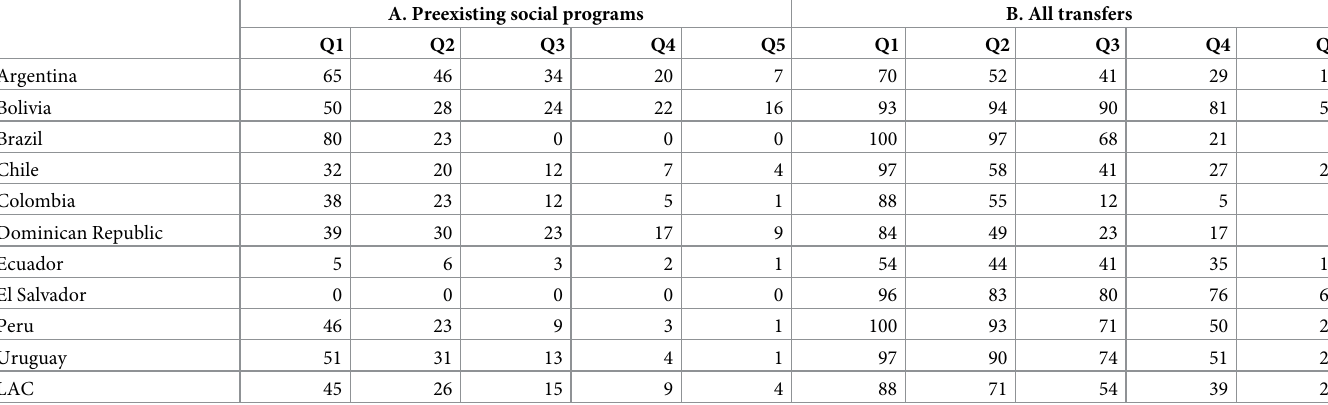
Table 5. Percentage of targeted households by type of monetary transfer, country and income quintiles.